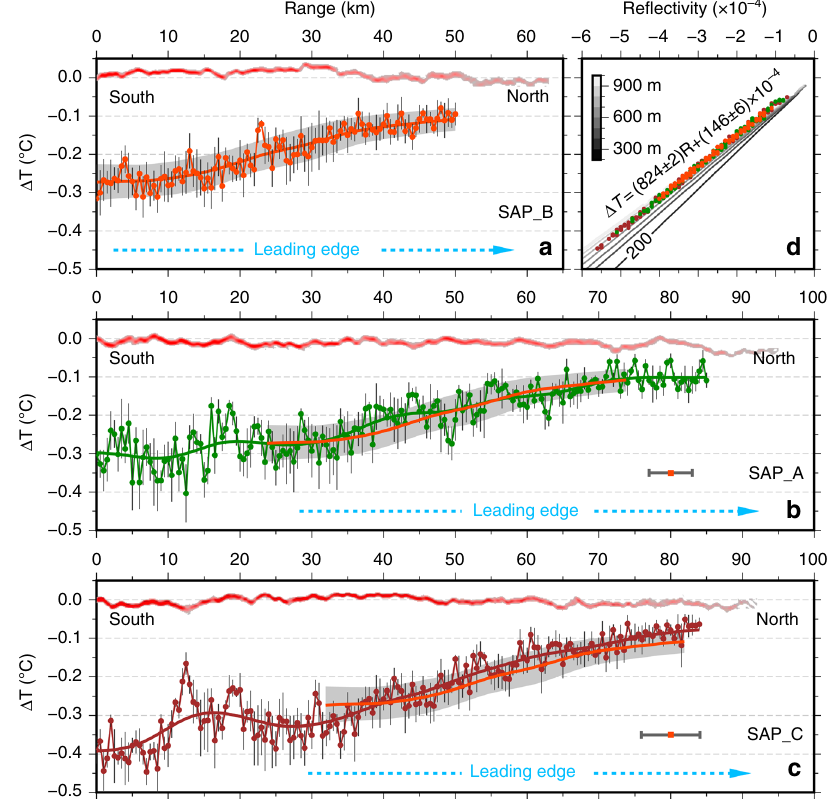
Fig. 4 Variations of the temperature contrasts ( Δ T ) along the seismic re fl ectors. a Δ T (orange dots with grey uncertainty bars of one standard deviation) derived from a combined AVO and Markov Chain Monte Carlo analysis (Supplementary Figs. 3, 4) for traced interface from seismic pro fi le SAP_B. The orange line and the grey band are the spatially smoothed Δ T and uncertainty, respectively. The tracked seismic re fl ection in Fig. 3a is also shown at the top of the panel. The blue arrow outlines the leading edge of the interface from the centre to the tip. b , c Same as ( a ) for seismic pro fi les SAP_A and SAP_C, respectively. The smoothed SAP_B re fl ection in ( a ) is displaced according to the current drifted offsets with the magnitude of the uncertainty in the location of this re fl ection represented by the orange dot with grey bar. d Plot showing the consistent and near-linear relationship between re fl ection coef fi cients and Δ T for all three re fl ections. Theoretical relationships between them at every 100-m depth are presented for reference (grey